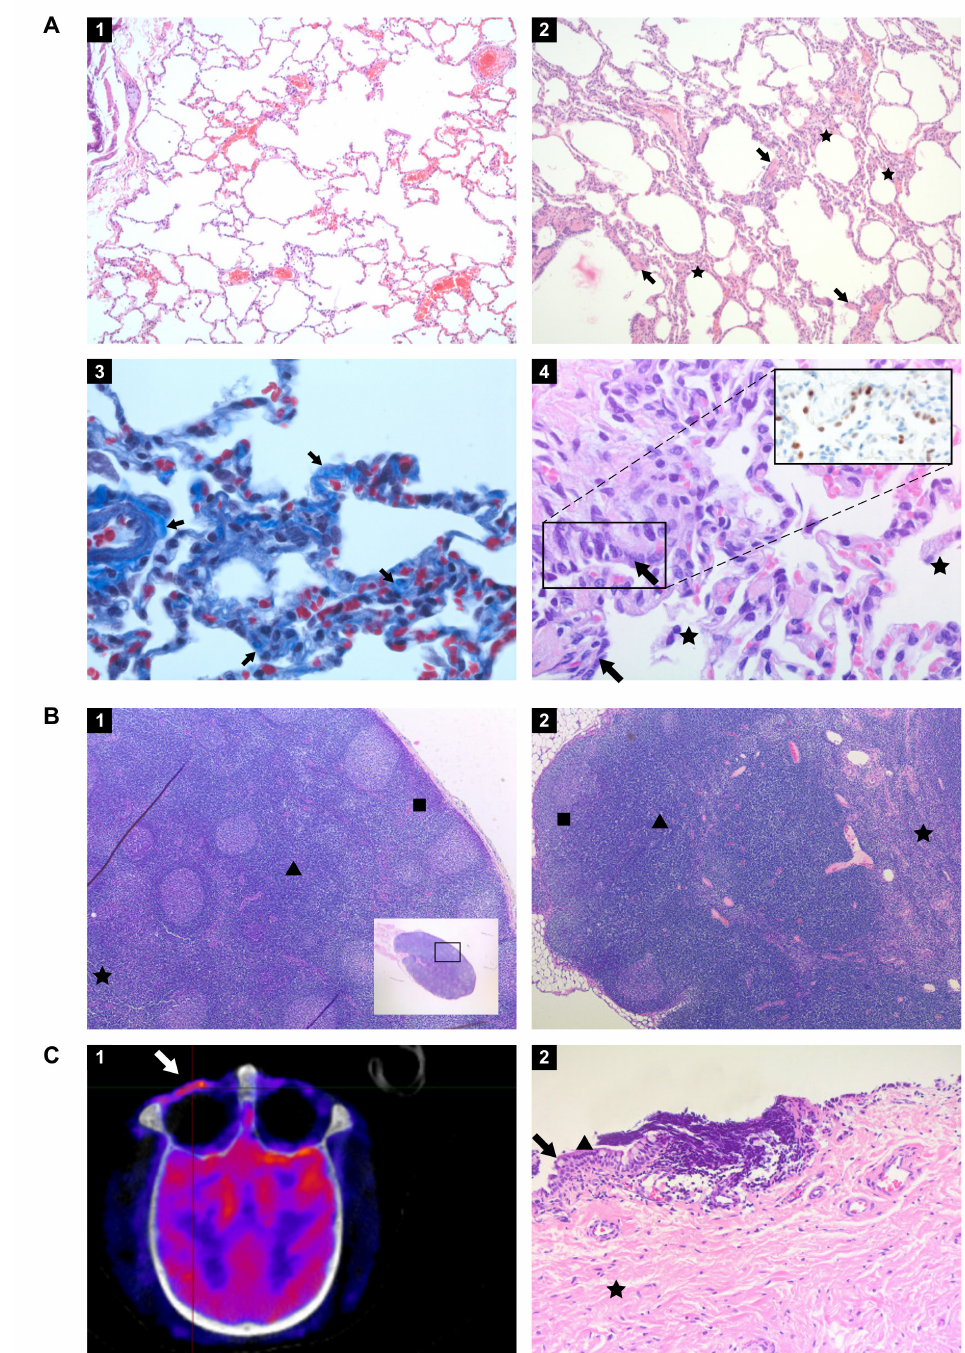
Figure 8. Histopathology of tissues from rhesus and cynomolgus macaques infected with SARS-CoV- 2 and euthanized 36 to 42 days post-infection. ( A ) Panel 1. Lung of healthy, uninfected macaque (Hematoxylin and Eosin (HE) staining, original magnification 100 × ); Panel 2. Lung of rhesus macaque infected with SARS-CoV-2 and euthanized day 36 pi. Focal area with mild alveolar septa expansion with a low number of mononuclear inflammatory cells (asterisks) and foci of bronchiolar smooth muscle hyperplasia (arrows) (HE, 100 × ); Panel 3. Masson’s trichrome staining shows the presence of collagen (lighter blue) mildly expanding the alveolar septa at some areas indicated by arrows. The internal control is the blood vessel on the left side with lighter blue staining of tunica adventitia (Trichrome stain, 630 × ); Panel 4. Lung of infected rhesus macaque with foci of mildly thickened alveolar walls lined by cuboidal to columnar epithelial cells with hyperchromatic